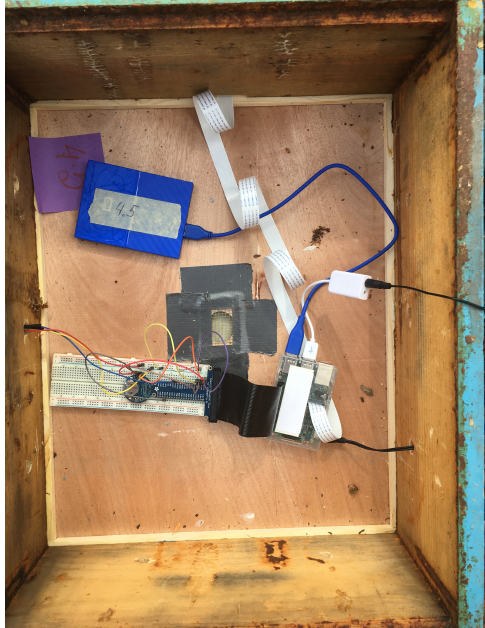
Figure 2. A BeePi monitor consists of a raspberry pi 3 model B v1.2 computer, a pi T-Cobbler, a breadboard, a waterproof DS18B20 temperature sensor, a pi v2 8-megapixel camera board, a v2.1 ChronoDot clock, and a Neewer 3.5 mm mini lapel microphone placed above the landing pad. More hardware details are available at